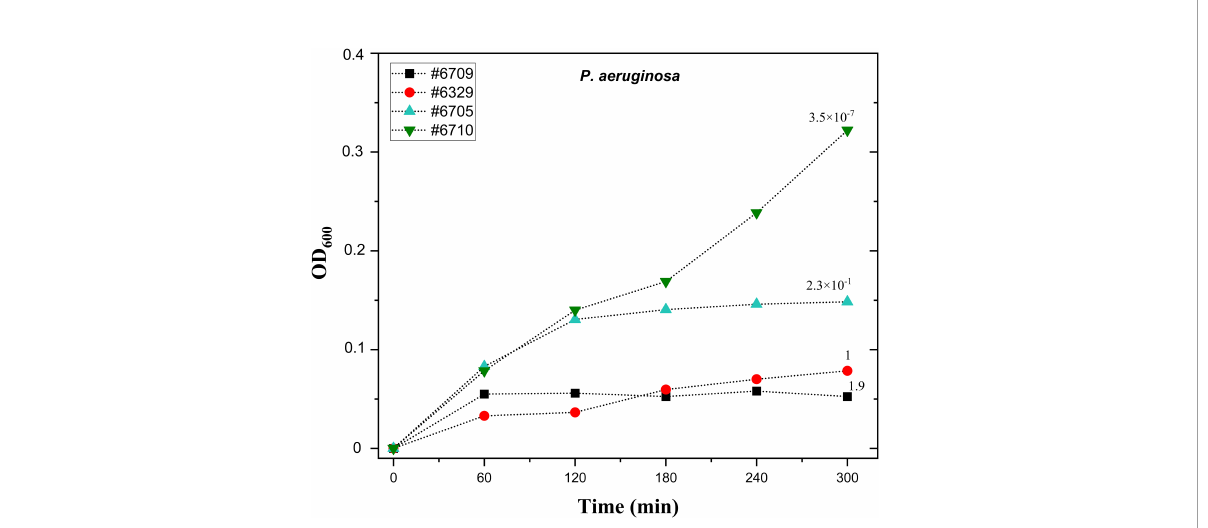
FIGURE 2 The correlation of liquid phage susceptibility test and ef fi ciency of plating with phage PA8P1. Ten µl droplets of PA8P1 (10 9 PFU/ml) were transferred onto the bottoms of microtiter plate wells. Overnight cultures of P. aeruginosa strains #6709, #6329, #6705, and #6710 were diluted 1:40, and 200 µl of the bacterial dilutions were added into the wells. The plate was incubated at 37°C and 200 rpm, and absorbance at 600 nm was measured at one-hour intervals. The numbers above each growth curve indicate ef fi ciency of plating (EOP) of PA8P1 in the corresponding strain, and its EOP in the original isolation host #6329 is denoted as 1. Each sample was analyzed in duplicate, and the mean is